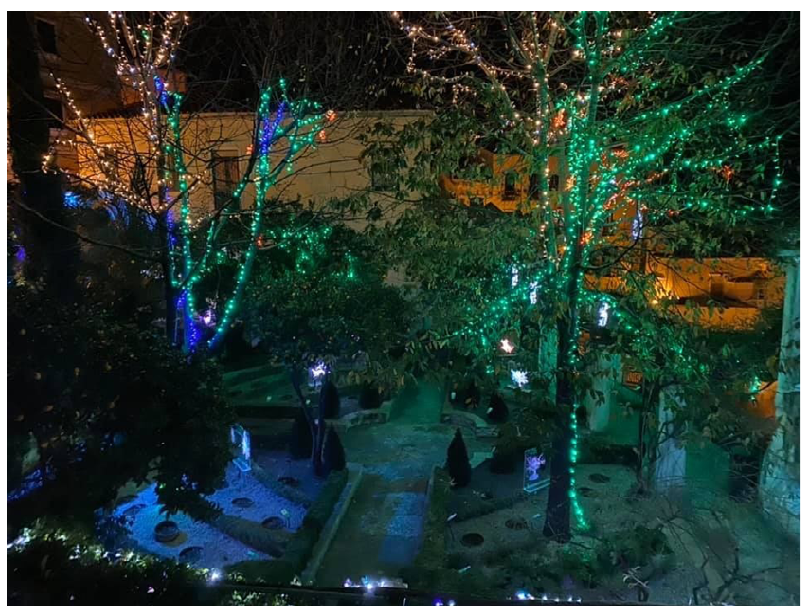
Minerva Garden, Salerno—Luciano